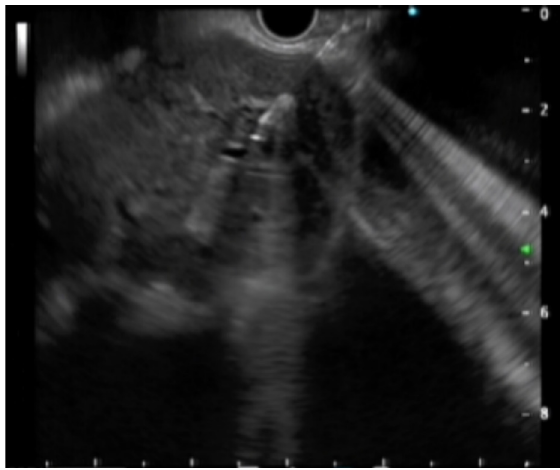
Figure 1. Ultrasound endoscopically guided intrahepatic bile duct puncture.